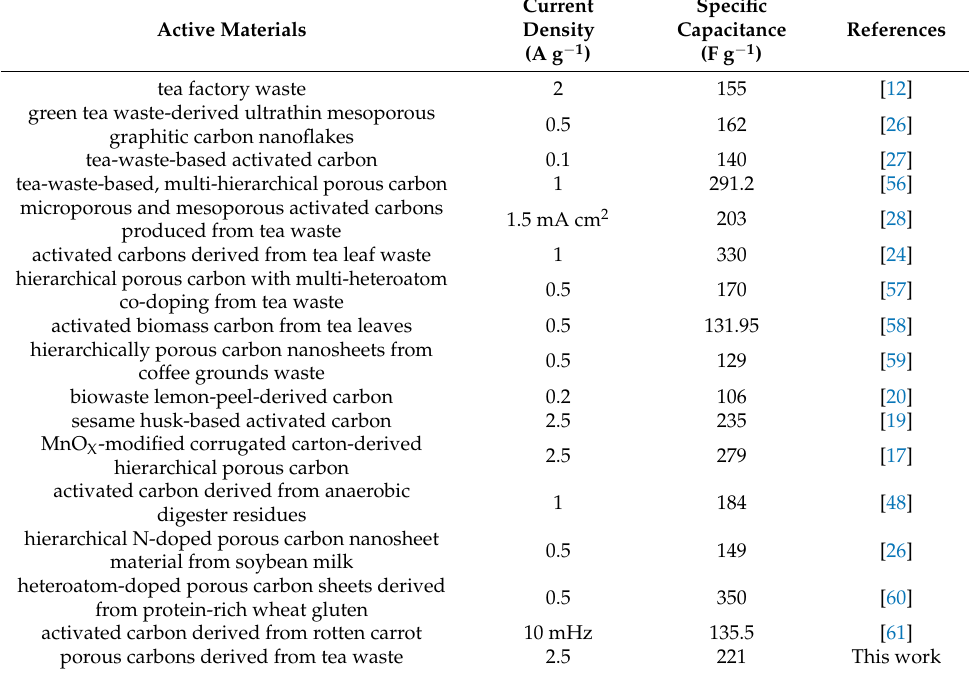
Table 3. The specific capacitances of the as-prepared carbon compared with those of the tea-waste- based carbon materials and other porous carbon